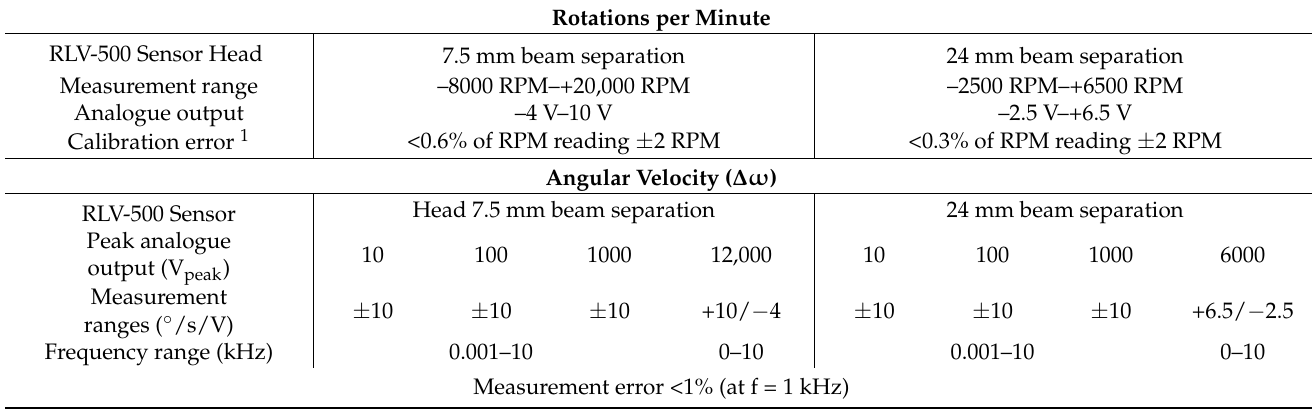
Table 2. Specification of the Polytec RLV-5500 rotational laser